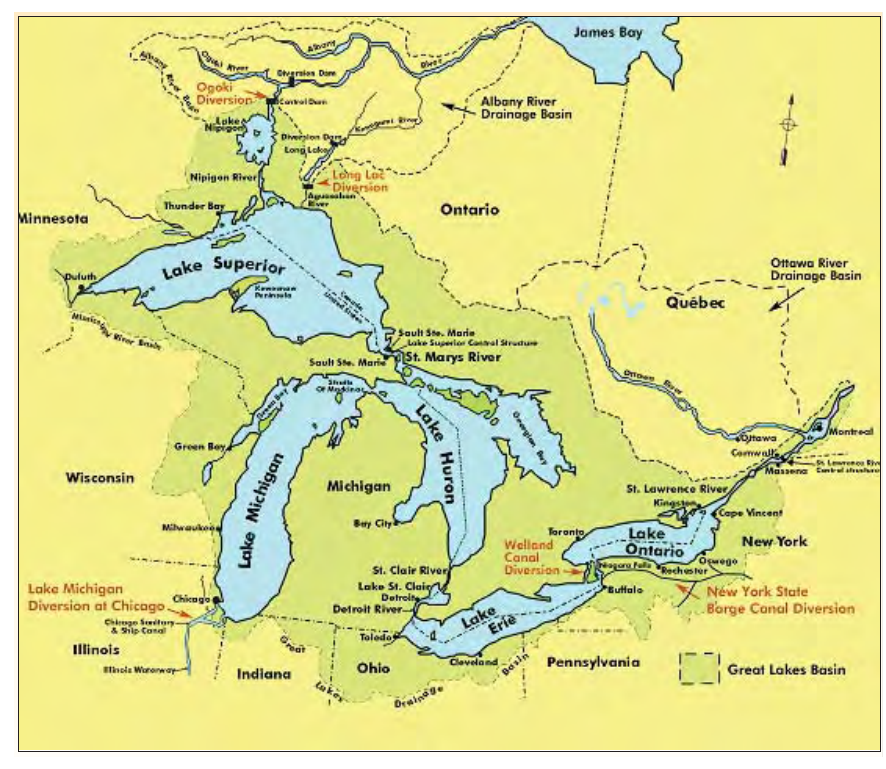
Figure 1. Map of the Great Lakes System [2]. Figure 2-4 Major Water Diversions in the Upper Great Lakes